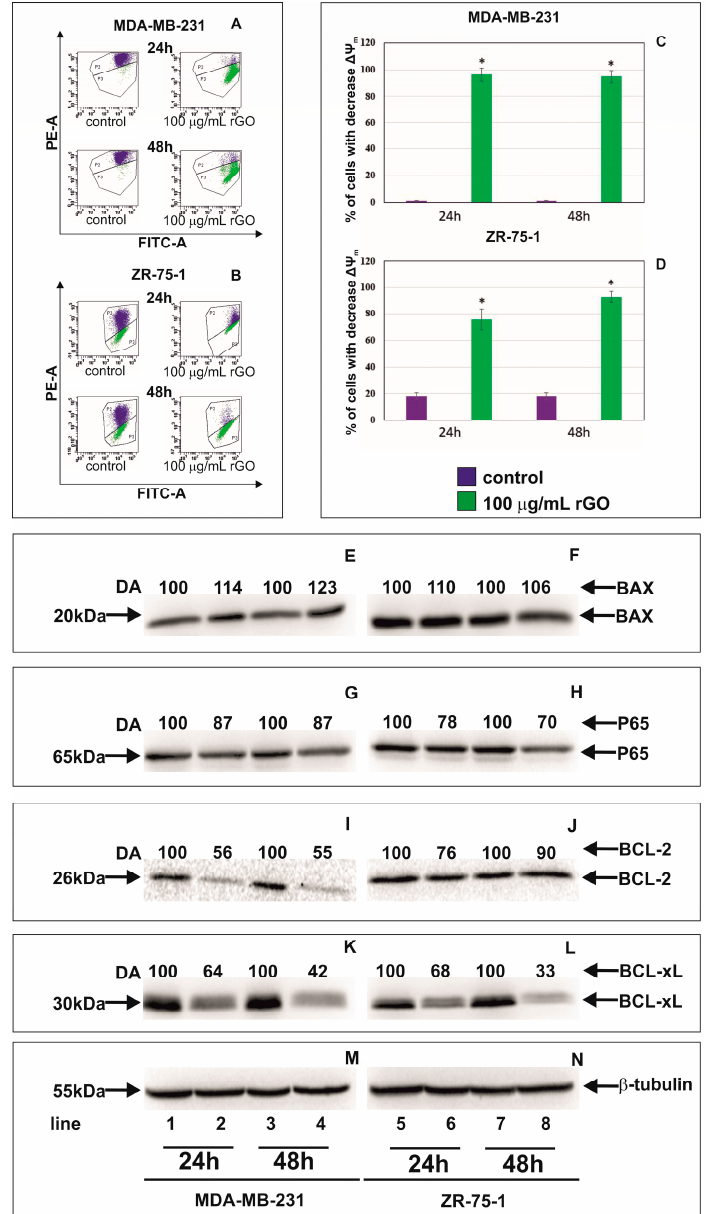
Figure 4. The effect of rGO on mitochondria dysfunction in MDA-MB-231 and ZR-75-1 cells. Cells were treated with 100 µ g/mL of rGO for 24 and 48 h. Panels ( A , B ) show the flow cytometry analysis of ∆Ψ m in MDA-MB-231 ( A ) and ZR-75-1 ( B ) cells. X-axis and Y-axis are green and red fluorescence, respectively. Gate P2—populations of cells with normal ∆Ψ m ; gate P3—population of cells with decreased ∆Ψ m . The right panels ( C , D ) show the percentage of MDA-MB-231 ( C ) and ZR-75-1 ( D ) cells with decreased ∆Ψ m . Panels E-L show the Western blot and densitometric analysis of BAX ( E , F ), P65 ( G , H ), BCL-2 ( I , J ) and BCL-xl ( K , L ) expression in MDA-MB-231 ( E , G , I , K ) and ZR-75-1 ( F , H , J , L ) cells incubated with 100 µ g/mL of rGO (lines 2, 4, 6 and 8), in comparison to the control cells (lines 1, 3, 6 and 7), for 24 and 48 h. Samples containing 15 µ g of protein were submitted to electrophoresis and immunoblotting. A representative Western blot is presented. Densitometric analysis was presented as a relative fold change in comparison to untreated controls, where expression level was set as 100. The expression of β -tubulin ( M , N ) served as a control for protein loading. The mean values of densitometric analysis from three independent experiments ± SD are presented. * p < 0.001.